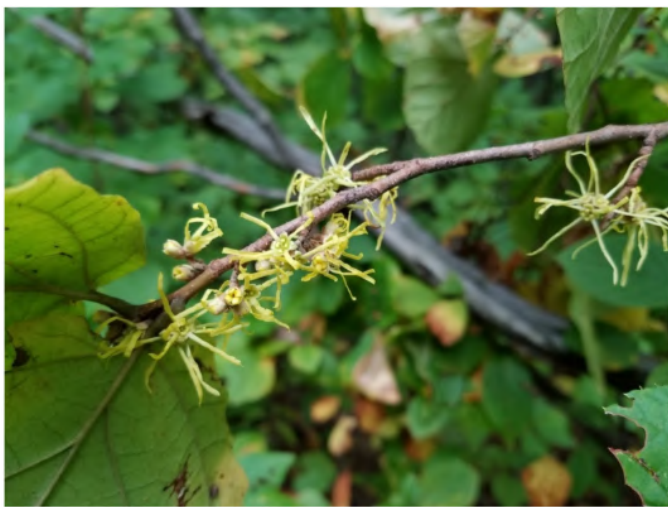
Figure 8. Hamamelis virginiana L.